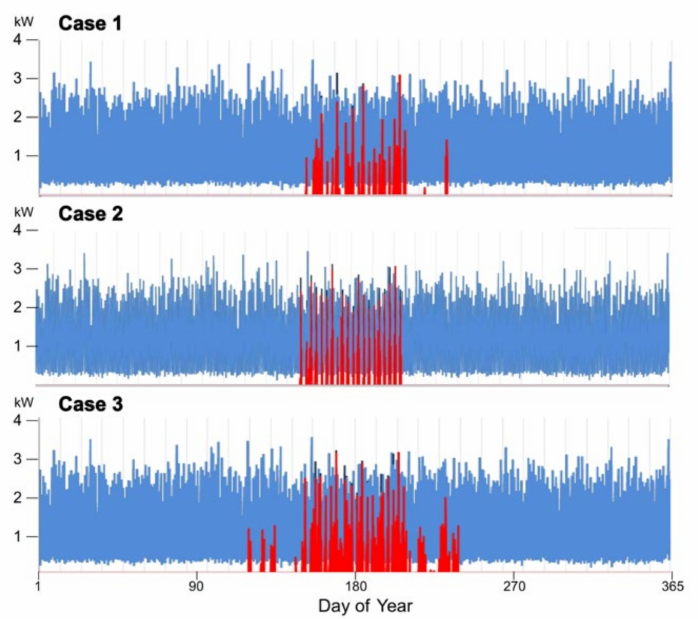
Figure 13. Annual profiles for load (in blue) and capacity shortage (in red) for HOMER-optimized cases 1, 2, and 3.